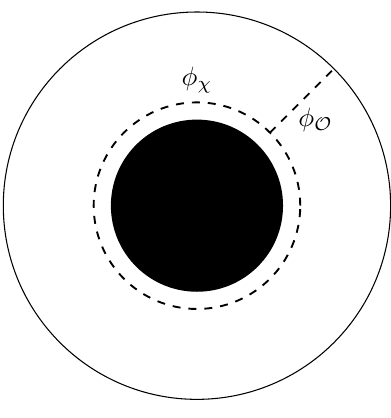
Figure 1 . A massive spinning particle (cid:30) a pair of particles (cid:30)